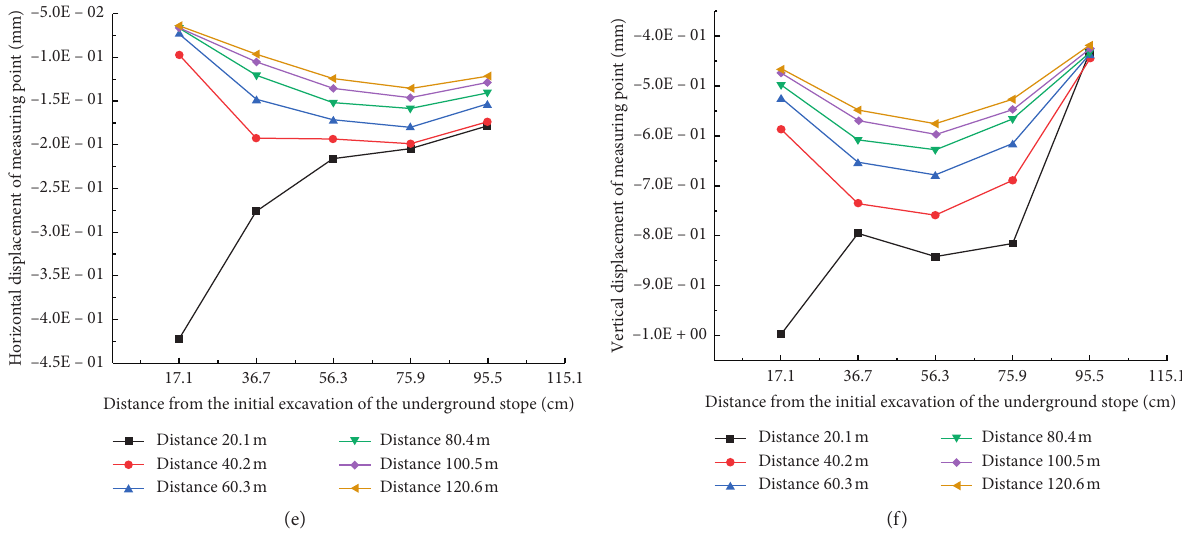
Figure 8: The model with a slope height of 200 m and a slope angle of 65 ° ; the three-stage mining displacement curve of the underground stope. Mining displacement curve in (a) the first stage, (b) the second stage, and (c) the third